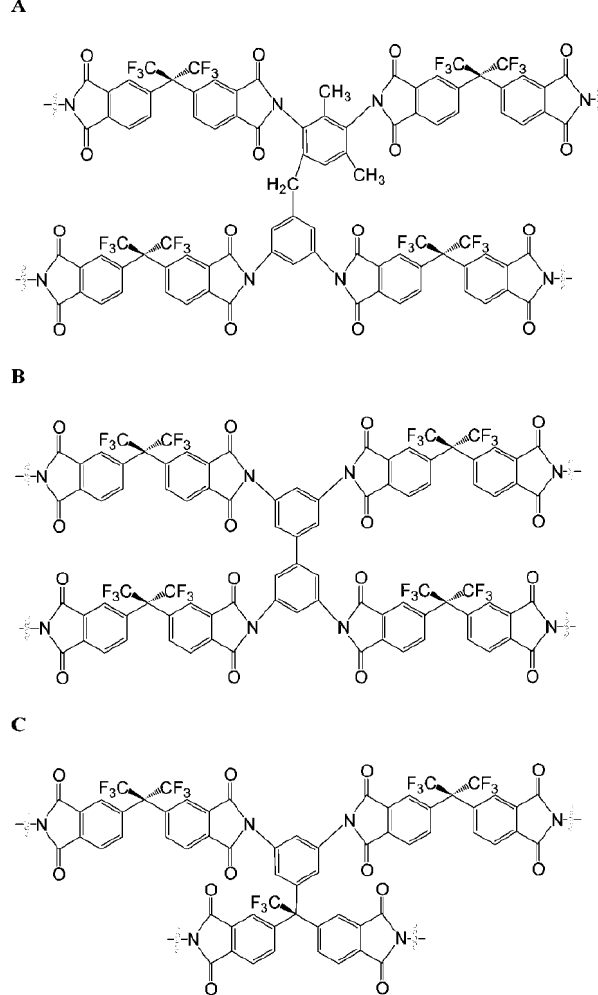
Figure 4 . Possible crosslinking sites through diamines in the free acid polymer: ( A ) through the DAM methyl; ( B ) biphenyl crosslink; and ( C ) at the cleaved CF 3 site [56].